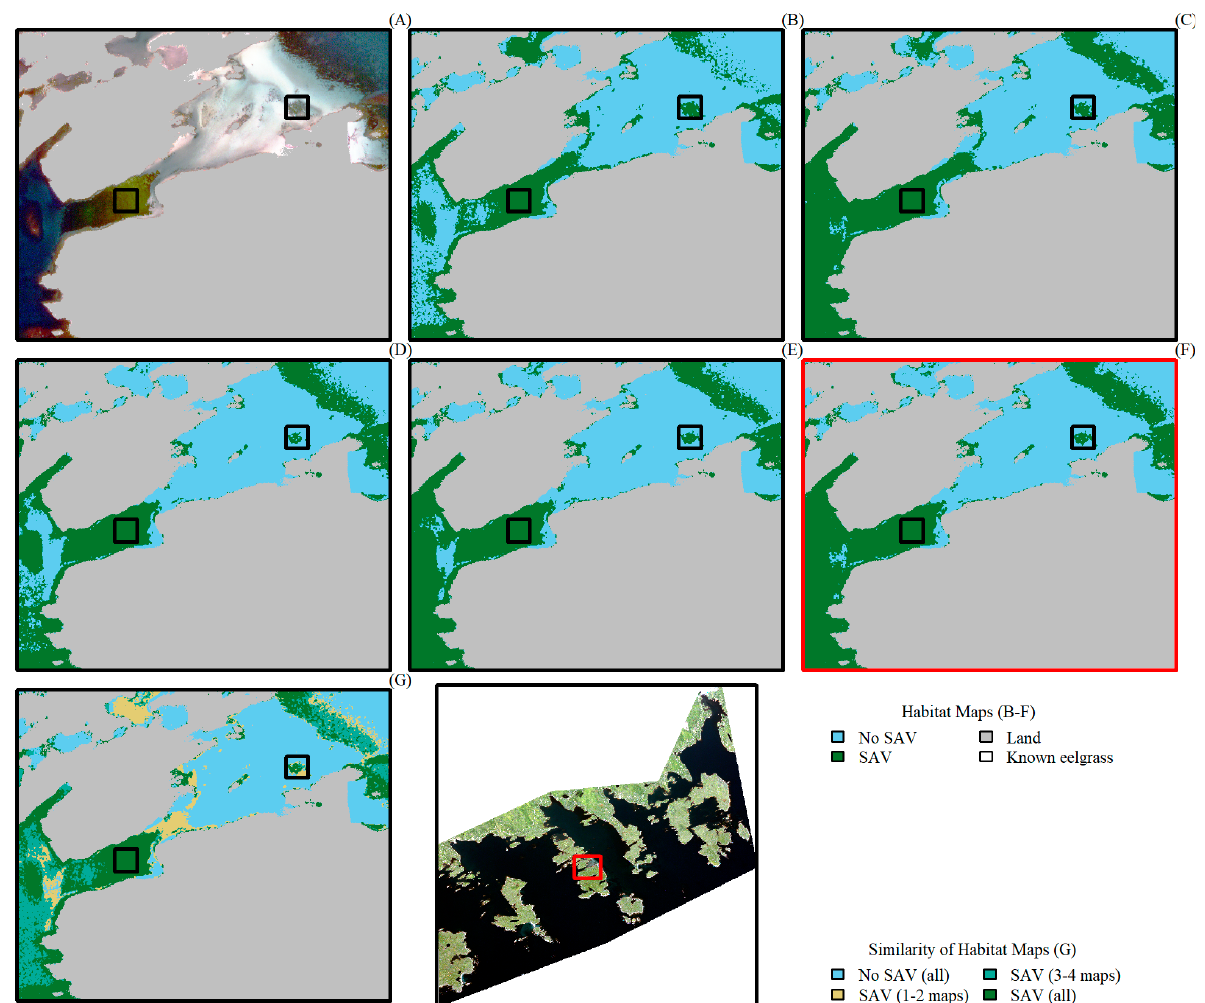
Figure 5. Representative bottom habitat classification with various input combinations for the 11 August WorldView-3 image indicating vegetation presence (SAV, green area) and absence (No SAV, light blue area), image-based land mask (grey), and the true colour composite ( A ). Bottom habitat classification on only the depth invariant indices (DII; ( B )); on the first four principal com- ponents (PC1-4; ( C )); the six spectral bands (6B; ( D )); the six spectral bands with the four principal components, the depth invariant indices, and satellite derived bathymetry (6B + PC1-4 + DII + SDB; ( E )); and the first two principal components, blue and green spectral bands, and the satellite derived bathymetry (BG + PC12 + SDB; ( F )). Comparison of the similarity between habitat maps where all habitat maps indicate vegetation absence (light blue), all indicate presence (dark green), and where the maps disagree (yellow: 1–2 maps predict presence; light green: 3–4 maps predict presence) ( G ). Known locations of vegetated habitat (specifically eelgrass) are indicated by the black boxes. Red outline ( F ) denotes the top performing classification.